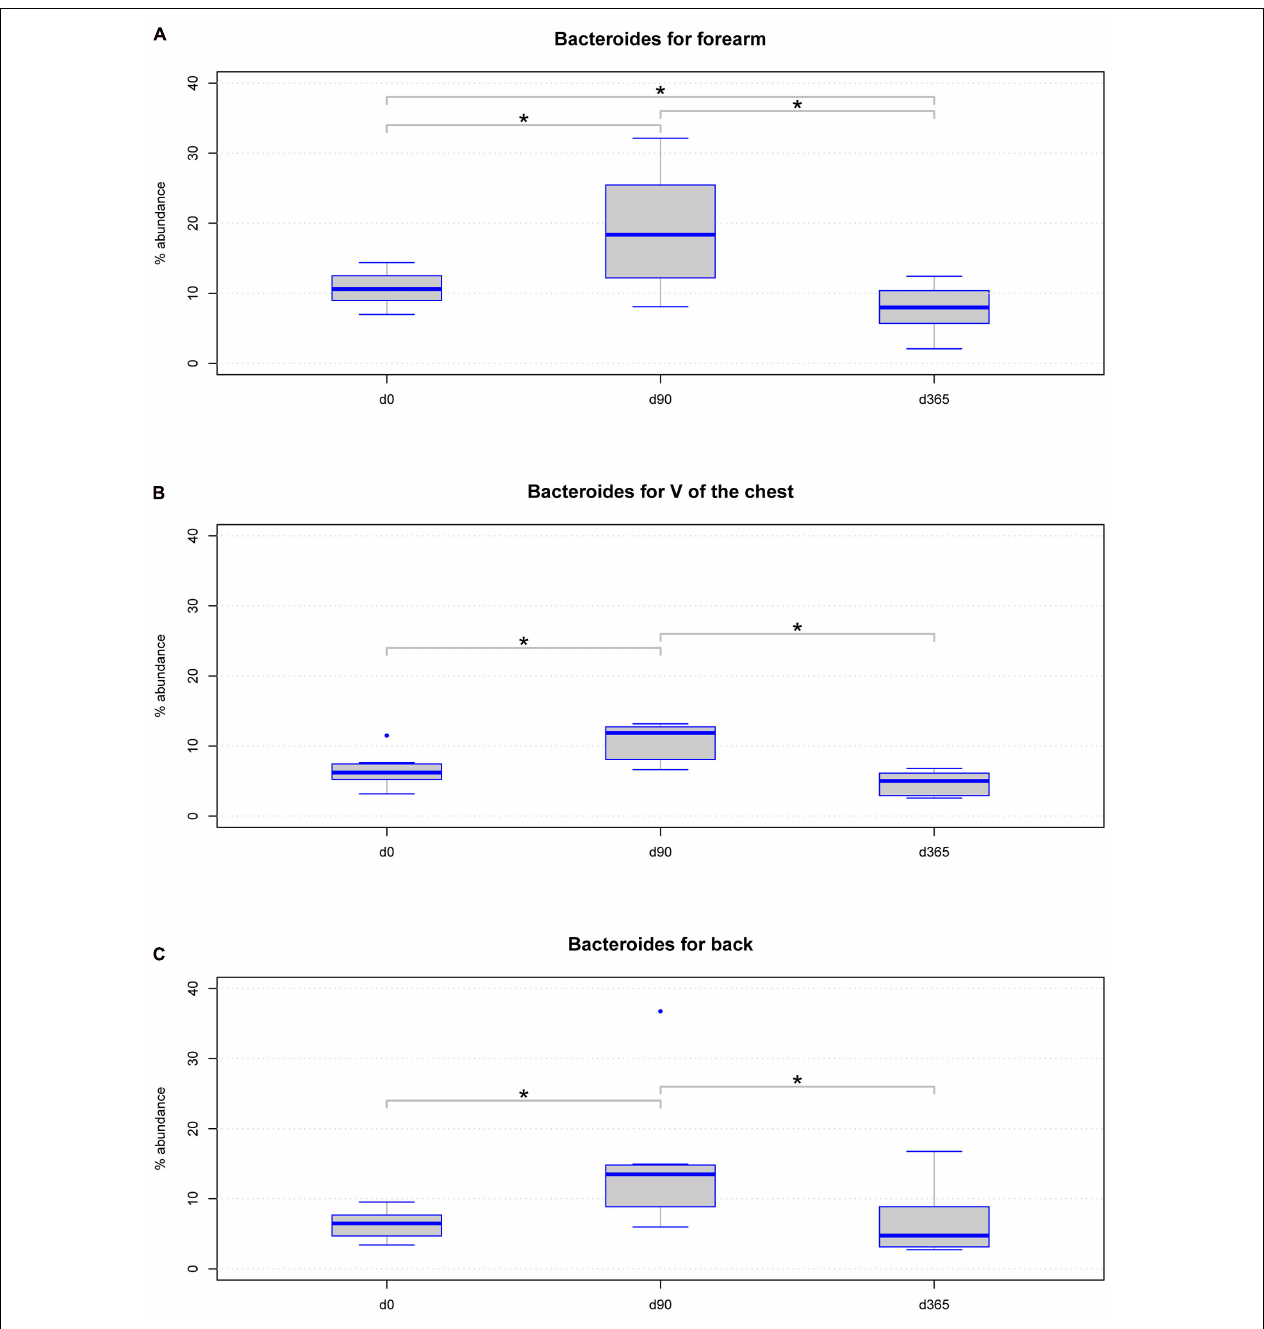
FIGURE 6 | Boxplot diagram for the relative abundance of the genus Bacteroides : this genus is significantly changed in samples from the three body locations (A) forearm ( p -value = 0.00033), (B) V of the chest ( p -value = 0.00463), and (C) back ( p -value = 0.0098) regarding the storage period using the Friedman statistical test. Significant differences ( p -value below 0.05) are marked with a line between the affected sample groups and an asterisk.